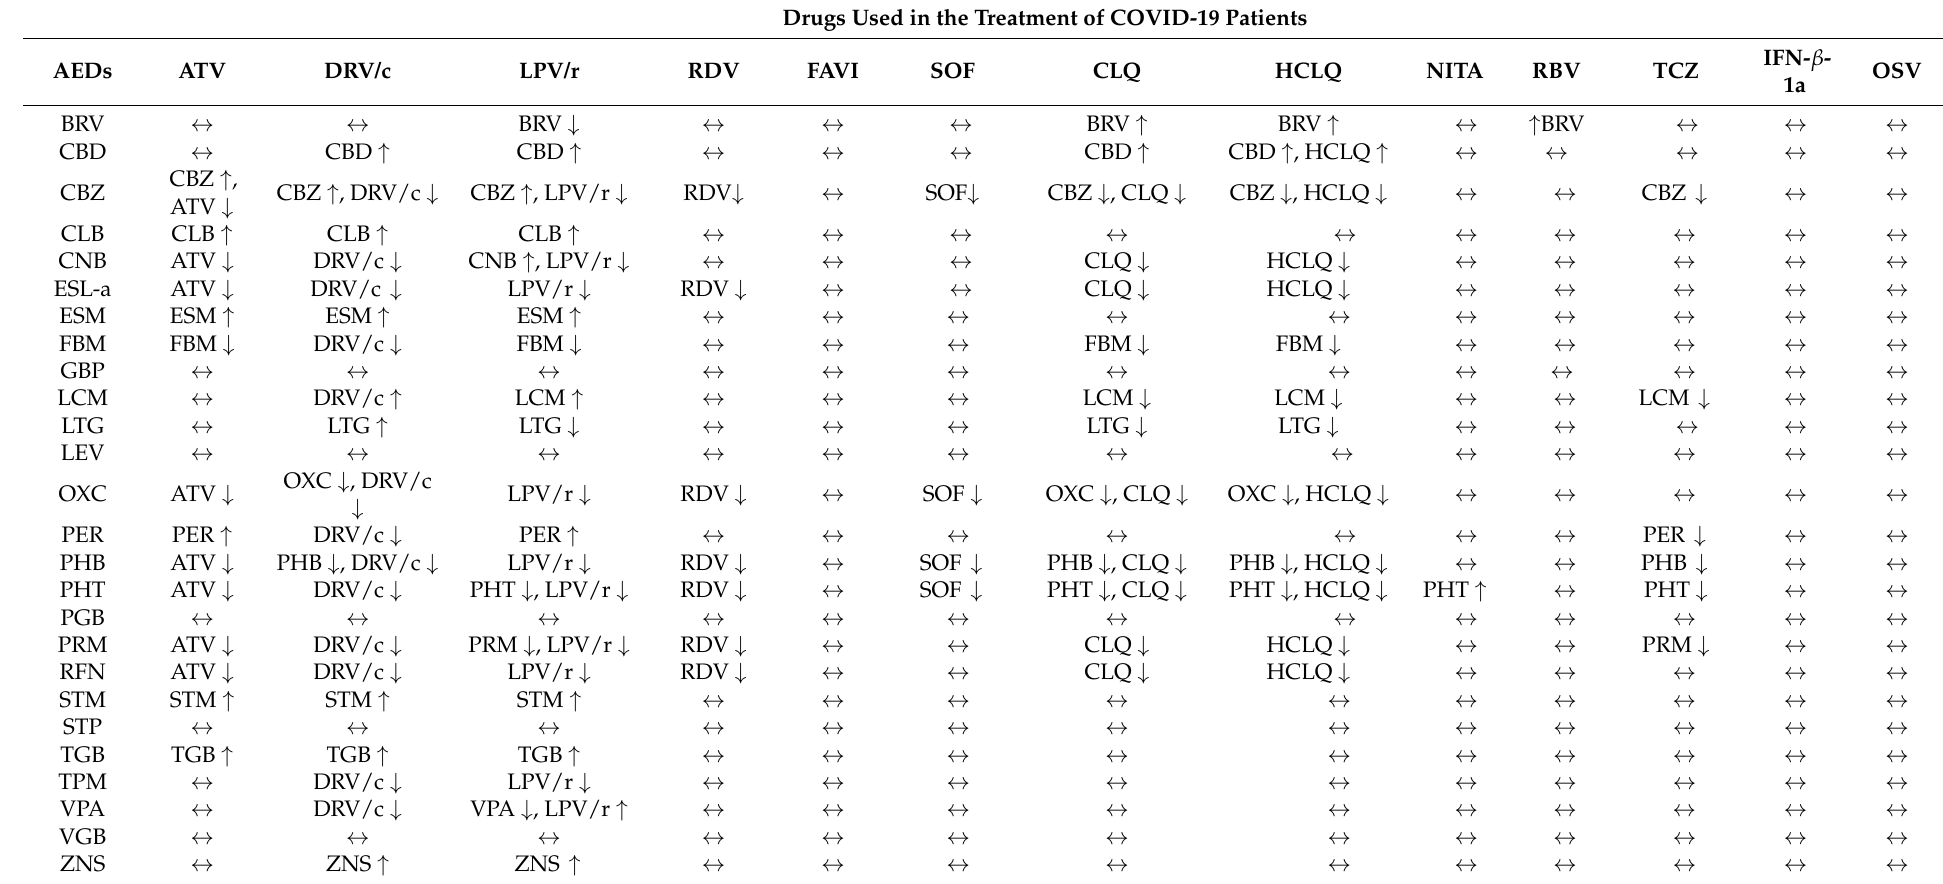
Table 3. Potentially relevant drug–drug interactions between AEDs and medications used in the treatment of COVID-19 patients [75,76]. Drugs Used in the Treatment of COVID-19